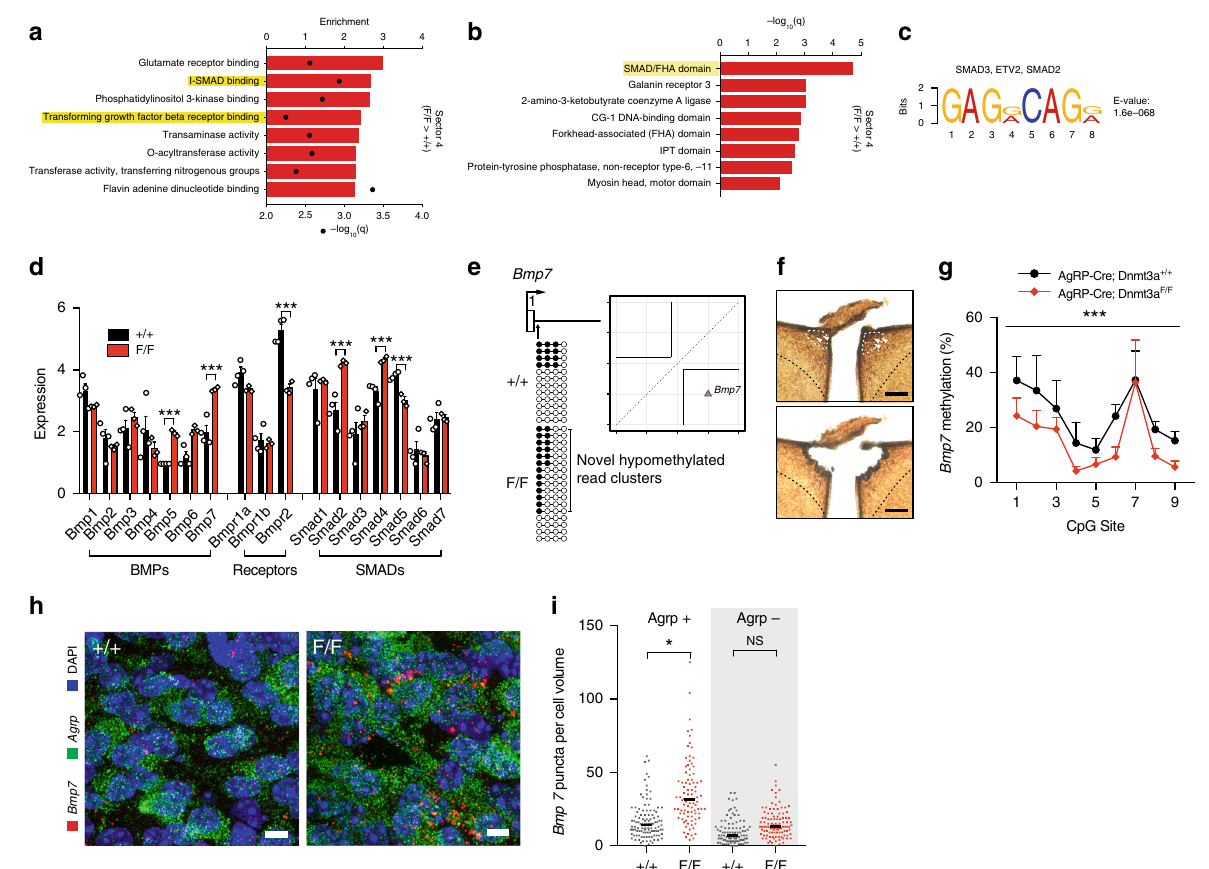
Fig. 5 Reduced Bmp7 methylation and increased expression in AgRP neurons lacking Dnmt3a . a Bins in sector 4 were associated with GO terms related to TGF- β and SMAD signaling. b Genes associated with sector 4 bins were enriched for proteins containing SMAD/FHA domains. c MEME-ChIP analysis shows that a SMAD2 and SMAD3 transcription factor binding motif is enriched among hypermethylated DMRs, suggesting that establishment of hypermethylation in F/F mice is downstream of TGF- β signaling. d Increased expression of bone morphogenetic protein (Bmp) signalers Bmp5 and Bmp7 , as well as downregulation of Bmpr1a and Bmpr2 receptor subunits and altered expression of Smad2, Smad4, and Smad5 . Values represent mean±SEM. e Gene diagram showing location of sector 2 bin in promoter region of Bmp7 . Tanghulu plots of read-level CpG methylation data show clusters of hypomethylated reads unique to F/F neurons. Inset: plot showing location of Bmp7 promoter bin in sector 2. f Representative photomicrograph showing immunohistochemical localization and laser capture microdissection of AgRP neuron-enriched mediobasal ARH. Arrows indicate AgRP neurons (identi fi ed by SynTom immunostaining). White dashed lines indicate AgRP neuron-rich mediobasal ARH boundaries. Black dashed lines indicate ARH neuroanatomical boundaries. Scale bars indicate 100 μ m. g Quantitative bisul fi te pyrosequencing of the Bmp7 promoter region identi fi ed in j (CpG positions 1 – 4) plus 100bp downstream (CpG positions 5 – 9). Linear mixed model analysis indicates signi fi cantly decreased Bmp7 methylation in the AgRP neuron-enriched mediobasal ARH ( + / + − F/F = − 37.1%±4.49, df = 18.3, p = 0.0002). Linear mixed models were calculated using animal ( n = 6 – 8) as a random factor. h Fluorescent in situ hybridization analysis of Agrp and Bmp7 co-expression. Scale bars = 10 μ m. i Linear mixed model analysis of fl uorescent in situ hybridization data shows increased Bmp7 expression in AgRP neurons ( + / + − F/F = − 17.55±6.68, df = 10.07, p = 0.025) but not in non-AgRP cells ( + / + − F/F = − 6.38±6.66, df = 9.89, p = 0.36). Linear mixed models were calculated using animal ( n = 3) as a random factor with n = 90 – 111 cells per condition); * p <0.05, *** p <0.001. Source data for d and g are provided as a Source Data fi